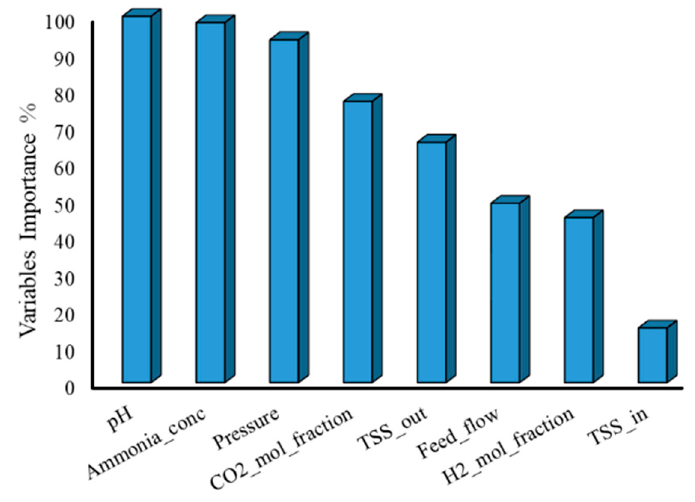
Figure 4. Importance of variables on a scale from 0 to 100 obtained with the fscaret method.